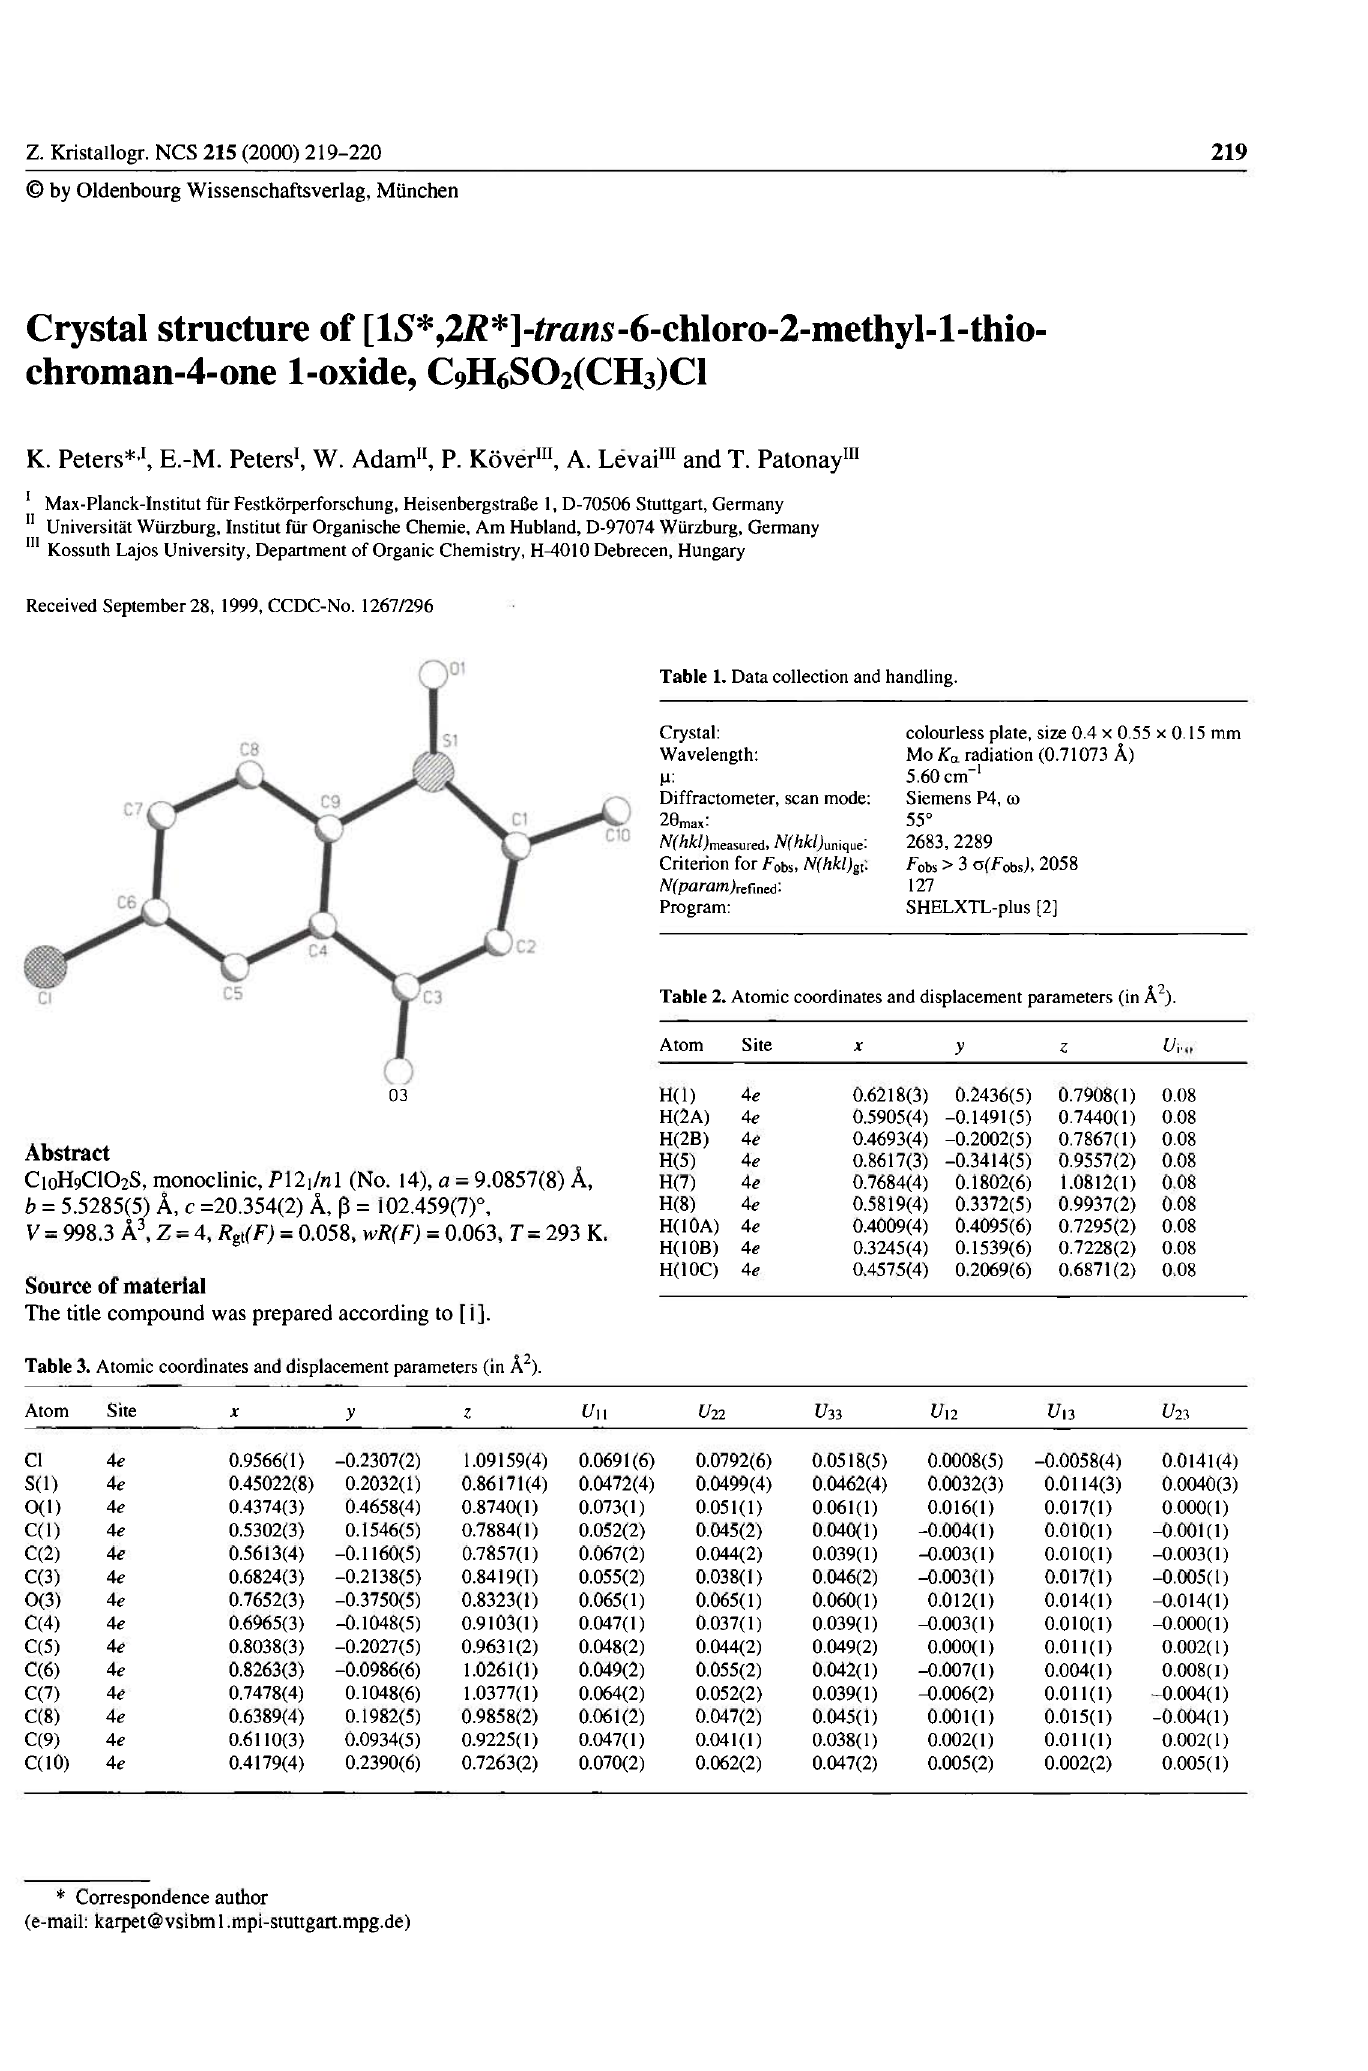
Table 2. Atomic coordinates and displacement parameters (in A 2